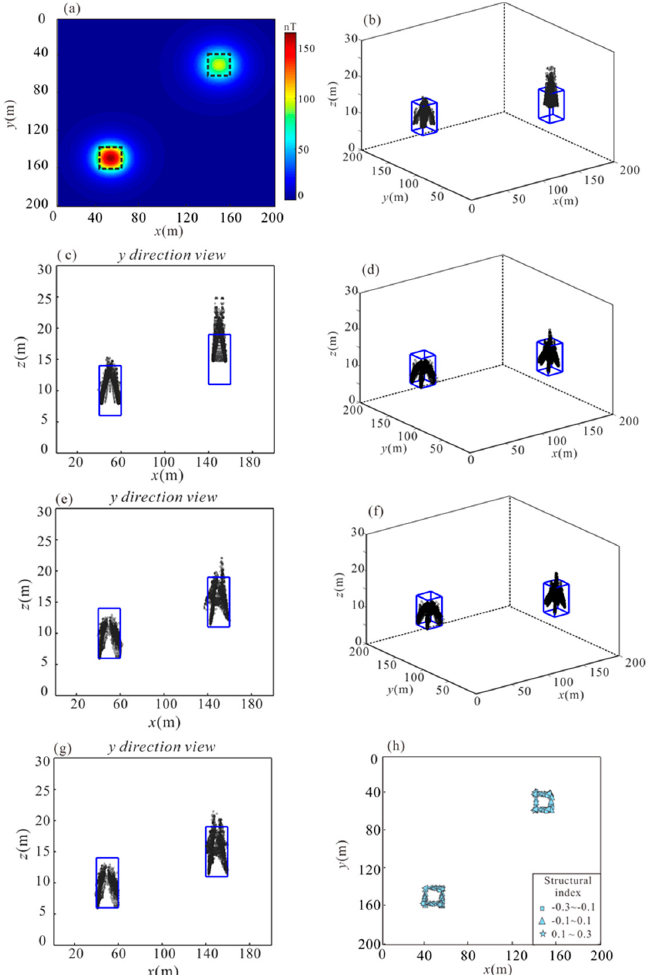
Figure 7. ( a ) The total field anomaly of two geological bodies having a magnetization inclined at 60 ◦ ; ( b ) source location results generated by estimator C1; ( c ) source location results generated by estimator C1 in y direction view; ( d ) source location results generated by estimator Cd; ( e ) source location results generated by estimator Cd in y direction view; ( f ) source location results generated by estimator Bd; ( g ) source location results generated by estimator Bd in y direction view; ( h ) statistics of structural index estimates generated by estimator